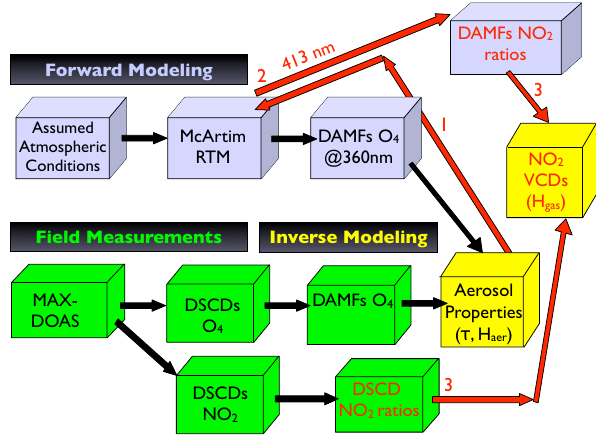
Fig. 3. Flowchart of methodology for determination of NO 2 VCDs and aerosol properties from MAX-DOAS measurements, RTM and inverse modeling. Measurements in green boxes represent products obtained from direct MAX-DOAS measurements in the field, while parameters and products shown in the grey boxes represent modeled quantities and results only. The quantities in the yellow boxes are obtained from inverse